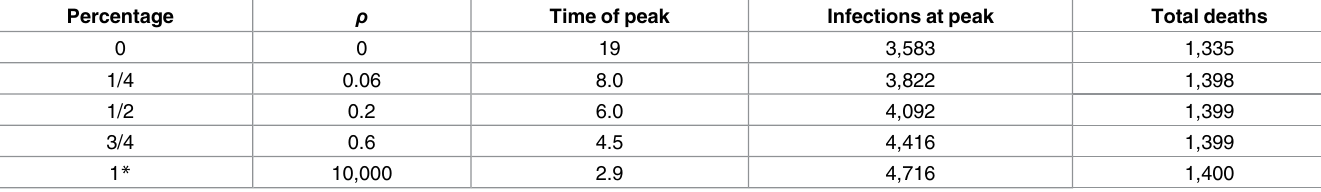
Table 3. Comparison of dynamics for varying levels of environmental transmission. The percentageof total infectionscaused by the environment is determined by the value of ρ . Total deaths are determined at t = 30 days. In all three cases, all turkeys become infected. * The numberof infectionscaused by direct transmission is less than 0.001.